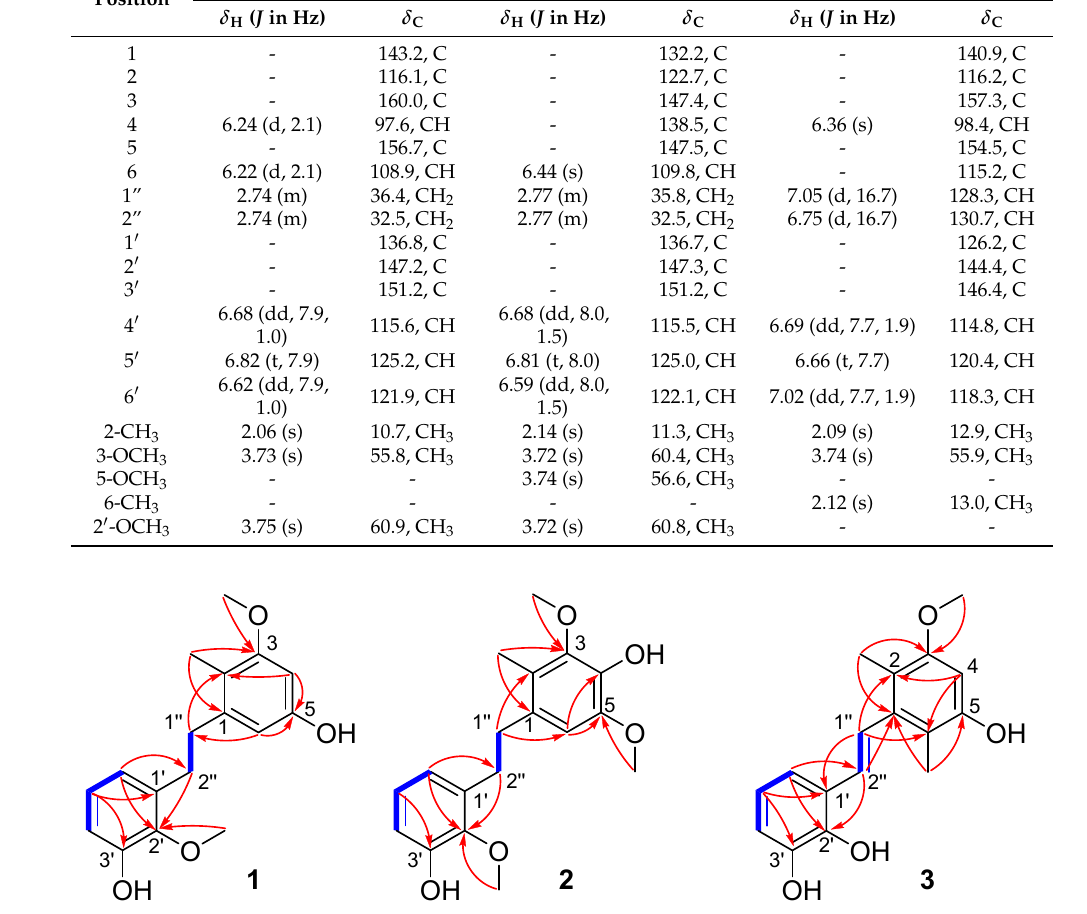
Figure 2. 1 H- 1 H COSY ( blue line ) and key HMBC ( → ) correlations of compound 1 – 3 .